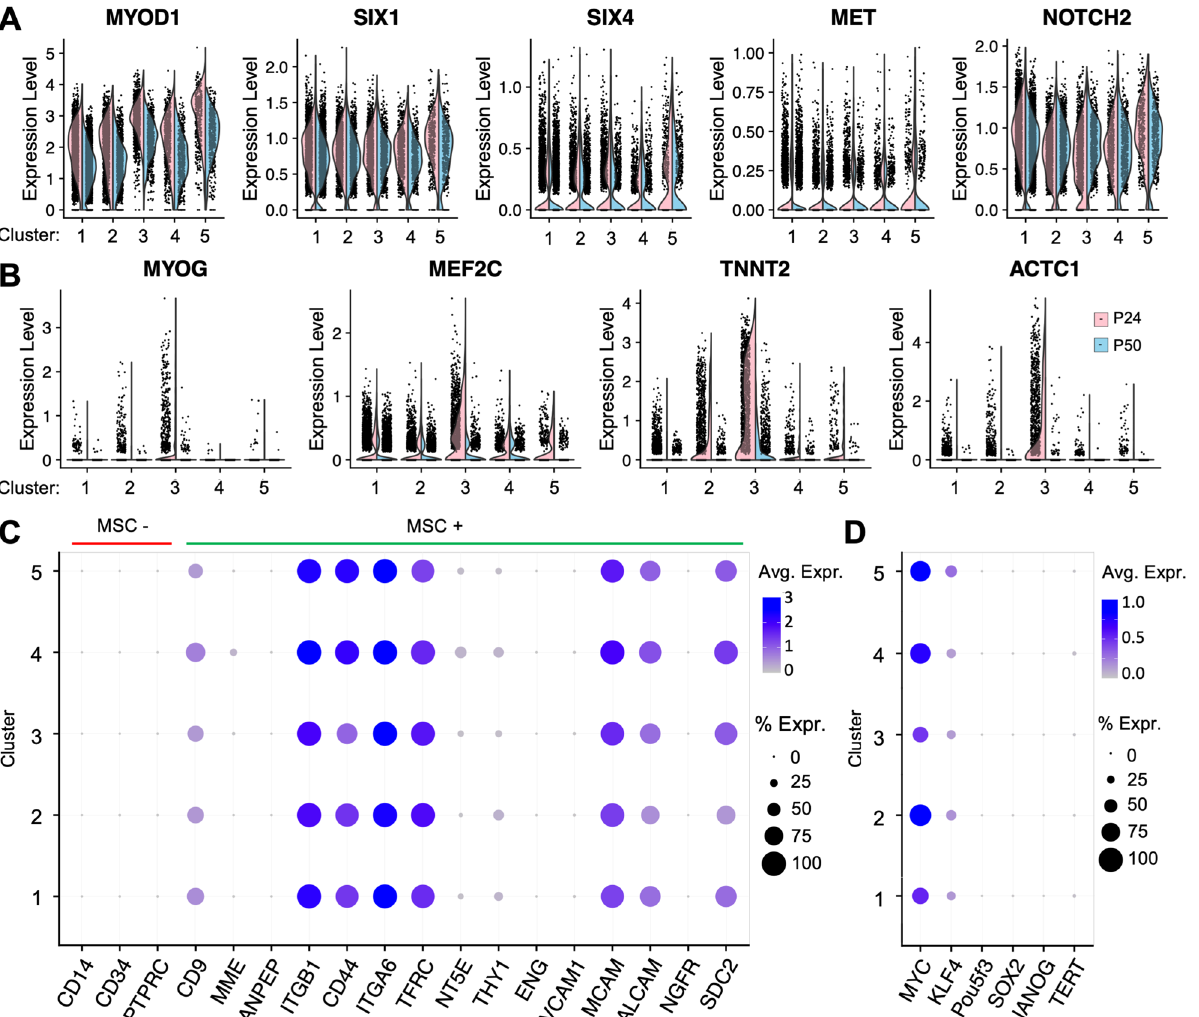
Figure 5. Myogenic cell identity of CFS414 cells. ( A ) Violin plots of myoblast gene markers in CFS414 cells, separated by cluster and passage. ( B ) Cluster 3-enriched myocytic gene markers. The bottom skew of the violin plots indicates cells with zero or near-zero expression. ( C ) Dot plot of negative (red line) and positive (green line) mesenchymal stem cell (MSC) markers in passage 24 CFS414 cells. ( D ) Dot plot of canonical pluripotency markers in passage 24 CFS414